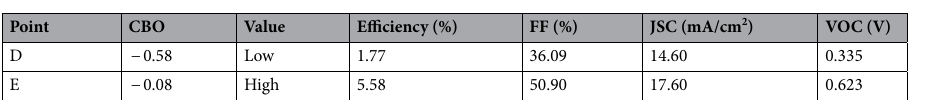
Table 2. Simulation characteristics of the CBT (S, Se) solar cells by utilizing the In 2 S 3 electron transport layer as a function of